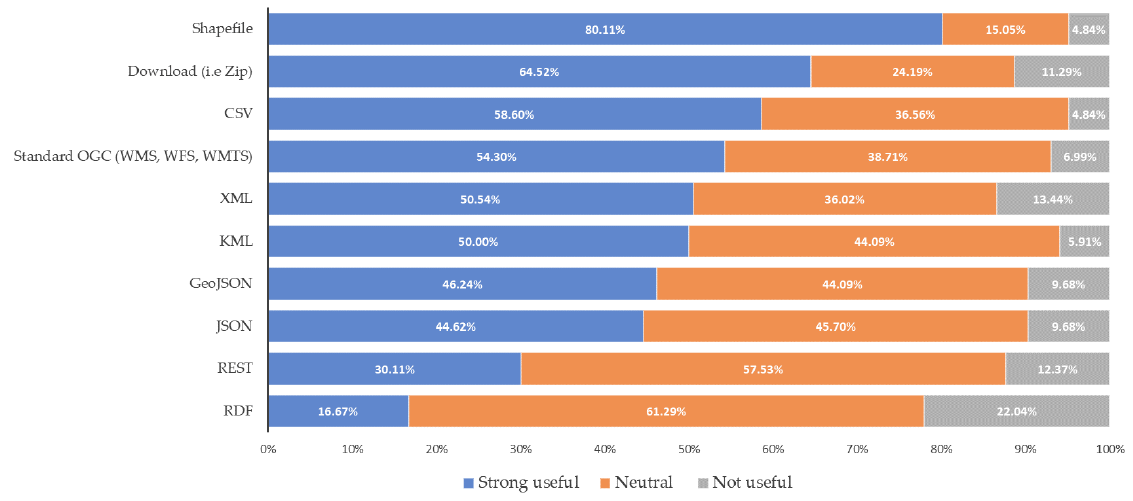
Figure 6. Formats or services mentioned by respondents as most useful for their work. Shapefile, .zip and CSV are considered strong useful ( n =